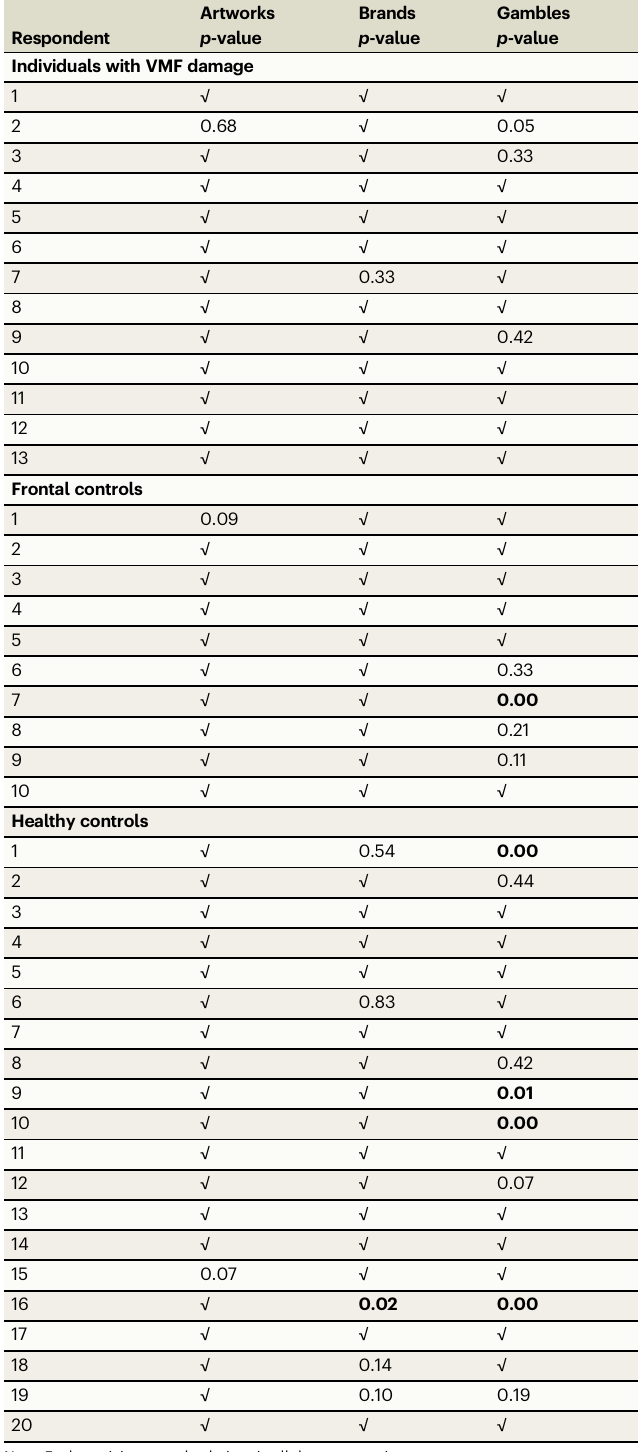
Table 3 | Results of LOP analysis by